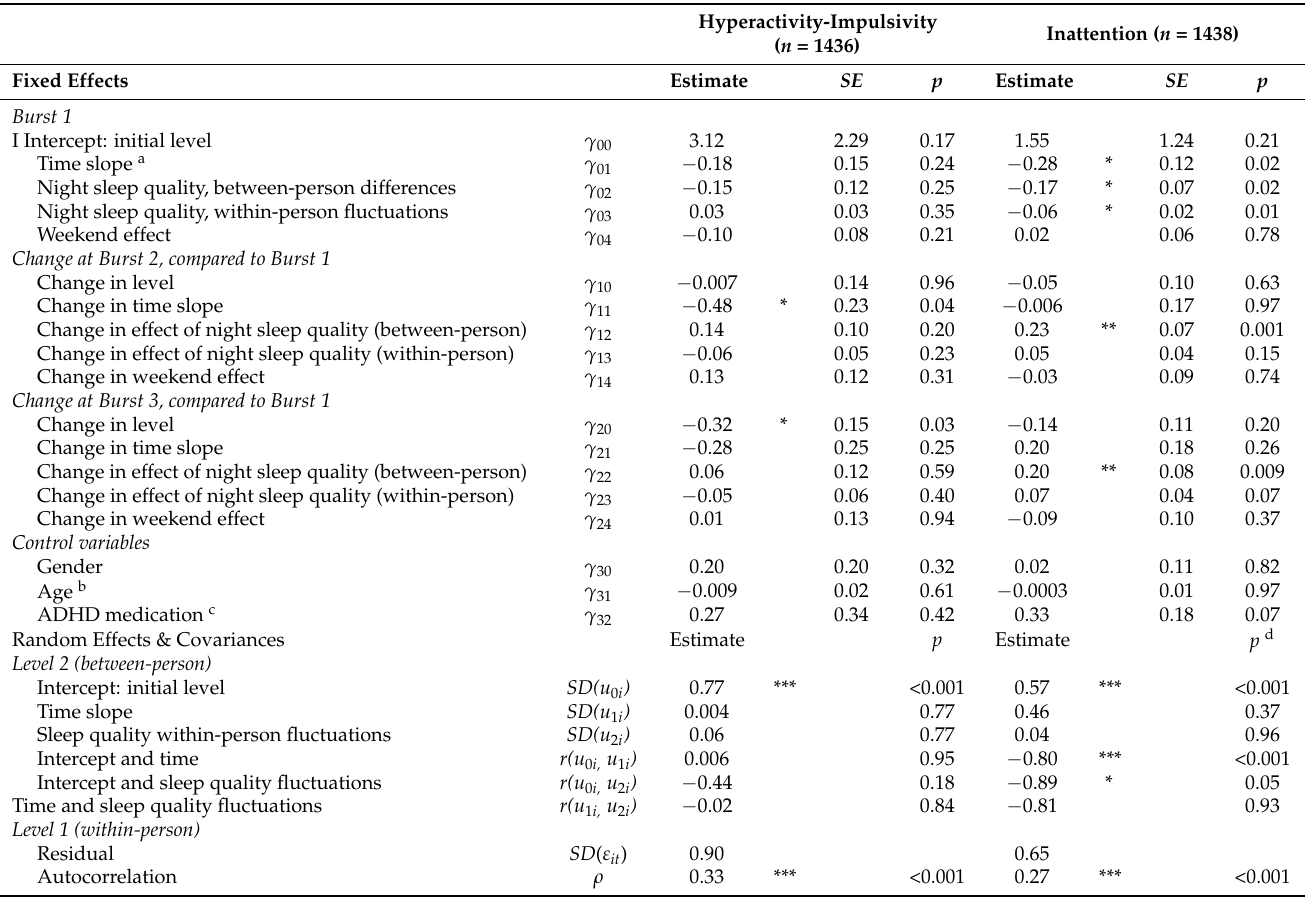
Table A1. Multilevel model to test the between- and within-person association between children’s night sleep quality and ADHD symptom levels, separately for symptoms of hyperactivity-impulsivity and inattention, the following